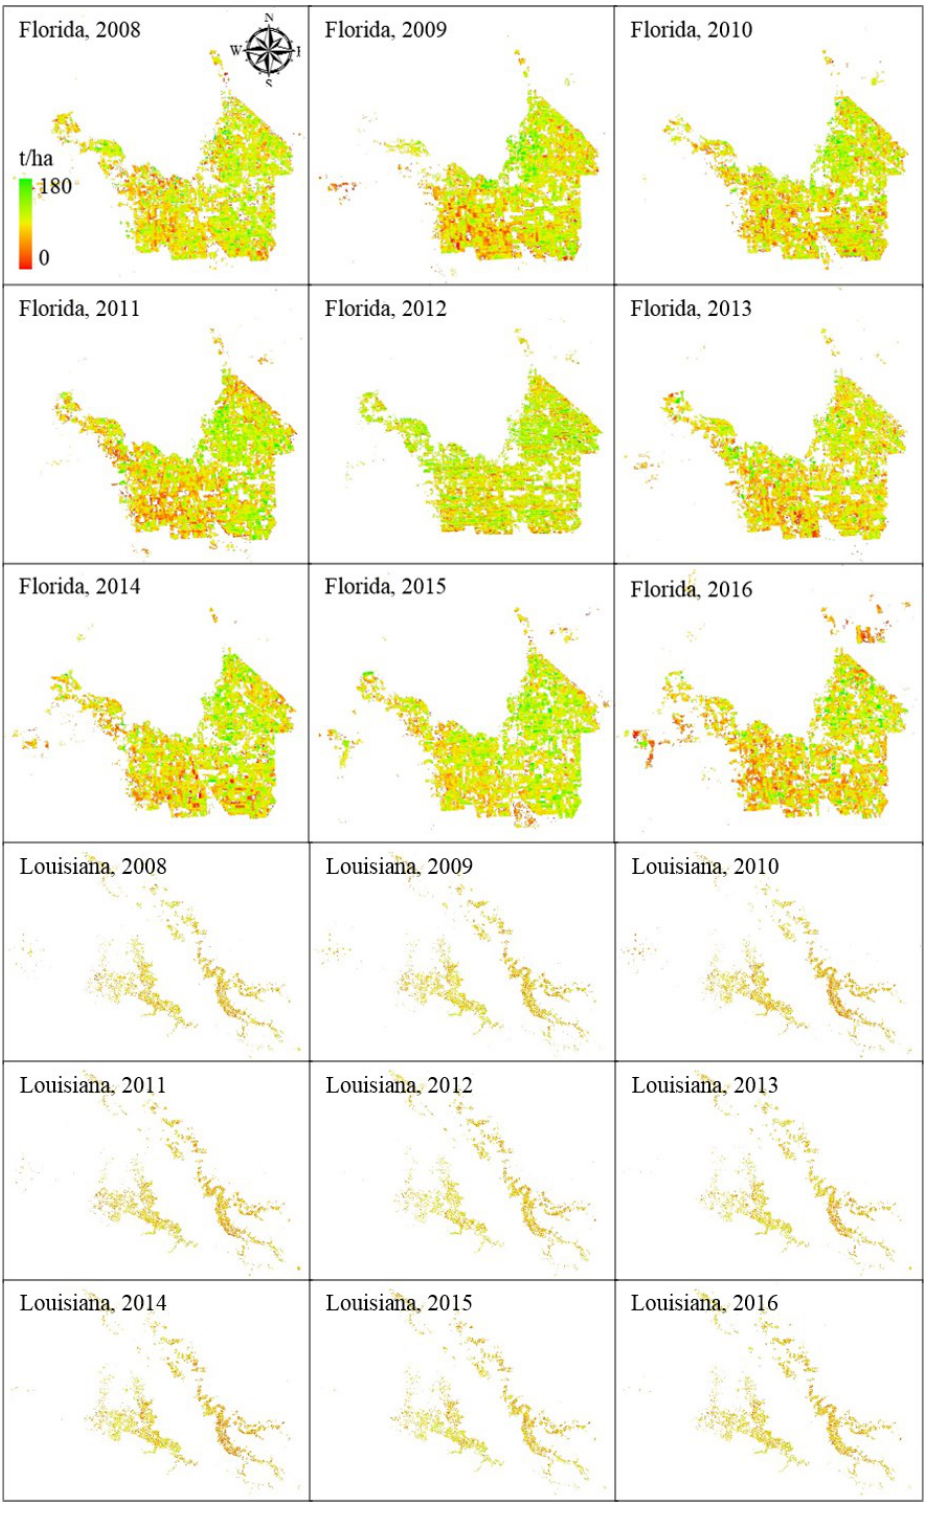
Figure 10. The predicted sugarcane yield maps using the SiPAR model in Florida and Louisiana from 2008 to 2016.